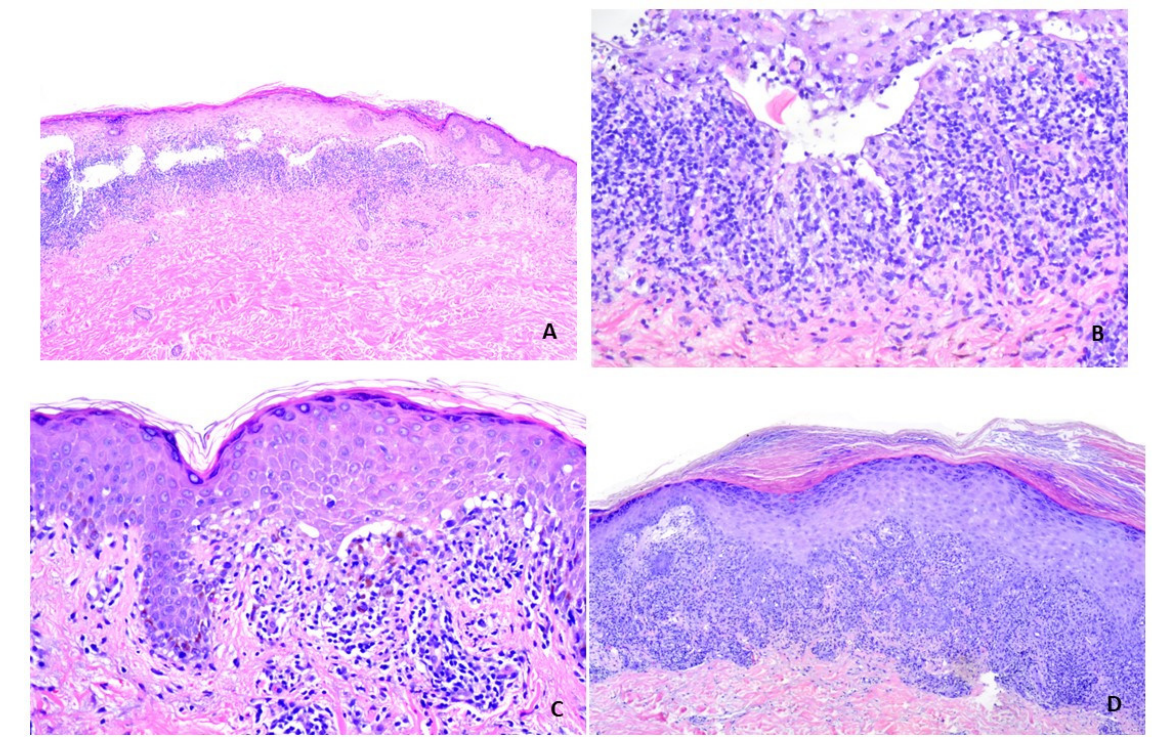
Figure 7. V-ILEs showing stereotypical features of LP. ( A , B ) , Case 3. ( A) There is a bandlike infiltrate associated with Max-Joseph spaces. (Hematoxylin-eosin stain; Original magnification, ×100). ( B ) There is a bandlike infiltrate associated with prominent Max-Joseph spaces, vacuolar change and necrotic keratinocytes. (Hematoxylin-eosin stain; Original magnification, ×100 ×200.) ( C ) Case 5. There is a bandlike infiltrate associated with Max-Joseph spaces and hypergranulosis. (Hematoxylin-eosin stain; Original magnification, ×200) ( D ) Case 7. There is a bandlike infiltrate associated with wedge-shaped hypergranulosis. (Hematoxylin-eosin stain; Original magnification, ×100).